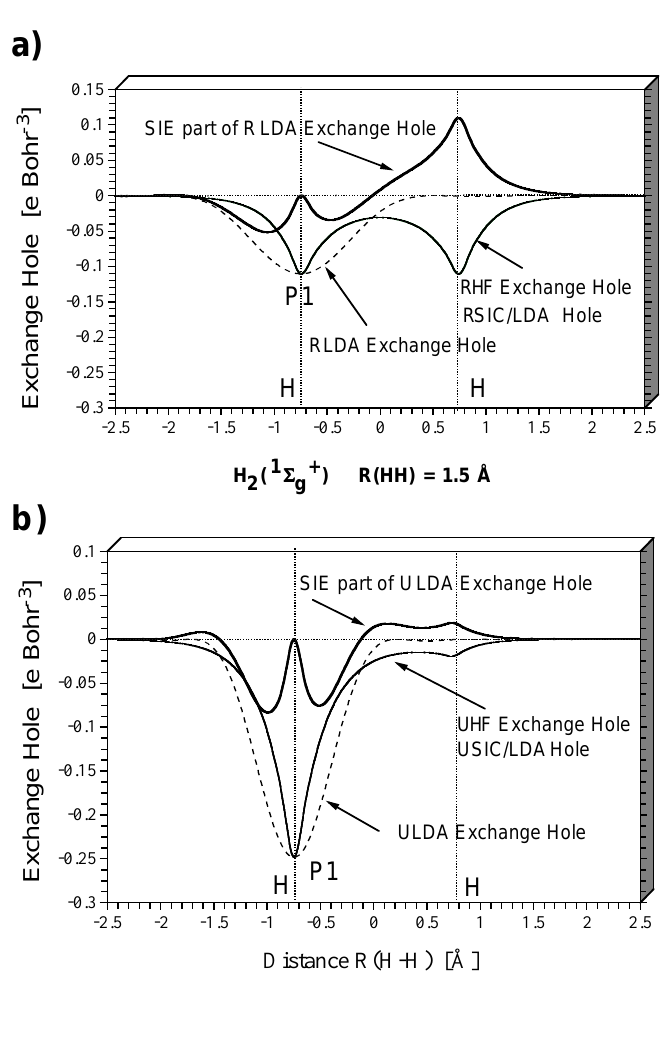
Figure 2: Parts a and b. For parts c and d and caption, see next